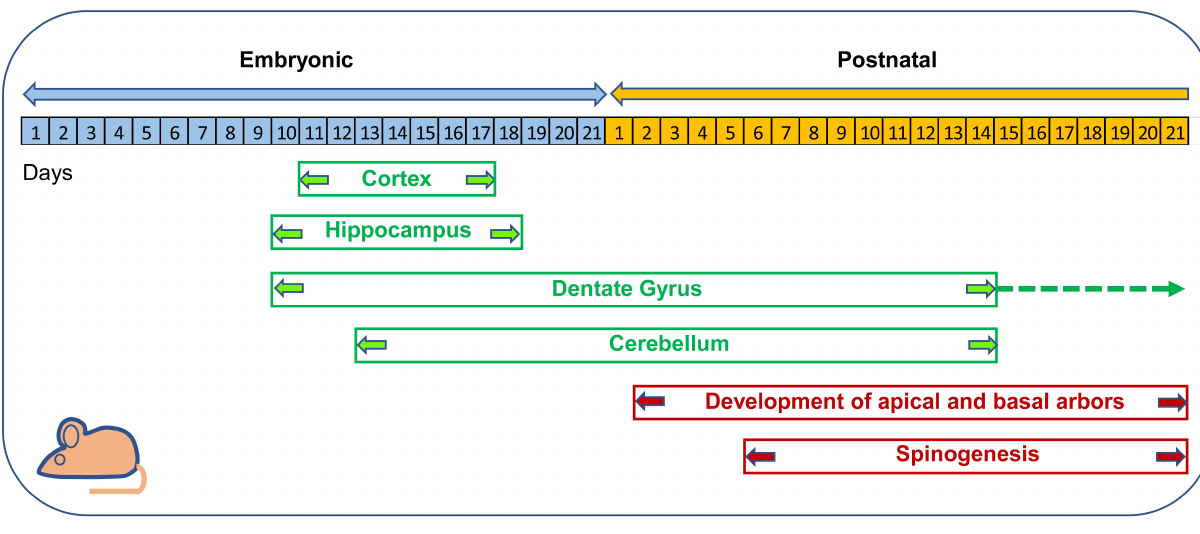
FIGURE 8 | Timeline of neurogenesis and neuron maturation in the mouse brain. Cortical neurogenesis takes place between embryonic (E) days E11–E17 (Takahashi et al., 1996). In the hippocampus proper neurogenesis takes place between E10–E18 (Angevine, 1965). In the hippocampal DG, neurogenesis begins at E10, exhibits its maximum rate in the first two postnatal weeks and then continues at a slow rate throughout life (Altman and Bayer, 1975, 1990a,b). In the cerebellum, granule cell production begins at E12.5 and E15.5 and is accomplished by the second postnatal week (Sillitoe and Joyner, 2007; Sudarov and Joyner, 2007). The basal and apical arbors of cortical pyramidal neurons appear at postnatal day 2 and attain maturation within the third week (Meller et al., 1969; Uguagliati et al., 2022). Cortical spinogenesis begins at postnatal days 6–9 and is completed by the third postnatal week (Meller et al., 1969; Uguagliati et al., 2022).